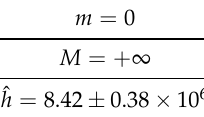
Table 2. Betz’s law parameters.